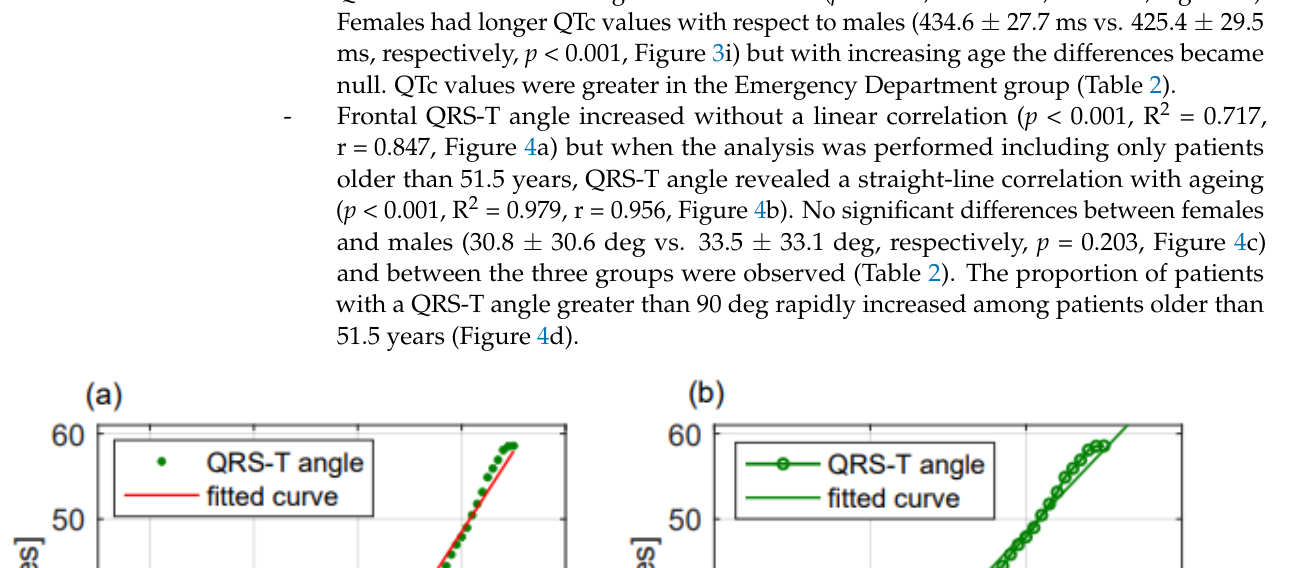
Table 3. Mean ECG values, computed in 15 age categories of 5 years each , of the parameters with a straight-line correlation with age and mean QRS-T angle values. For each age category, in the upper line, means ± standard deviation in the whole population; in the bottom line, means ± standard deviation in males and females. Age (Years)